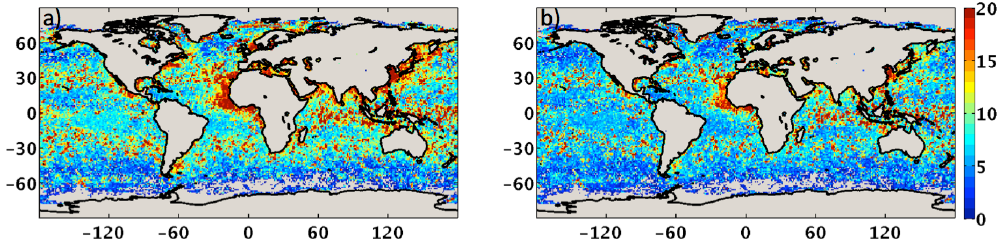
Figure 2. The rms error between normalized measured radiances and normalized ADM-predicted radiances, (a) using ADMs from Loeb et al. (2005), and (b) using the new ADMs. All clear-sky footprints from Terra RAP measurements in 2002 were used.